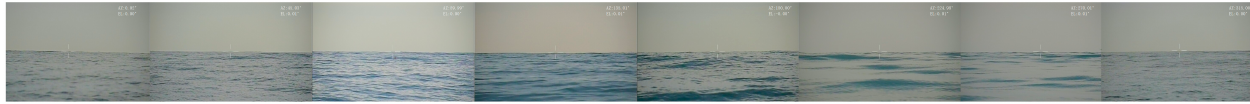
Figure 10. Circumferential scanning image after the electro-optical device corrects the perpendicu- larity error.